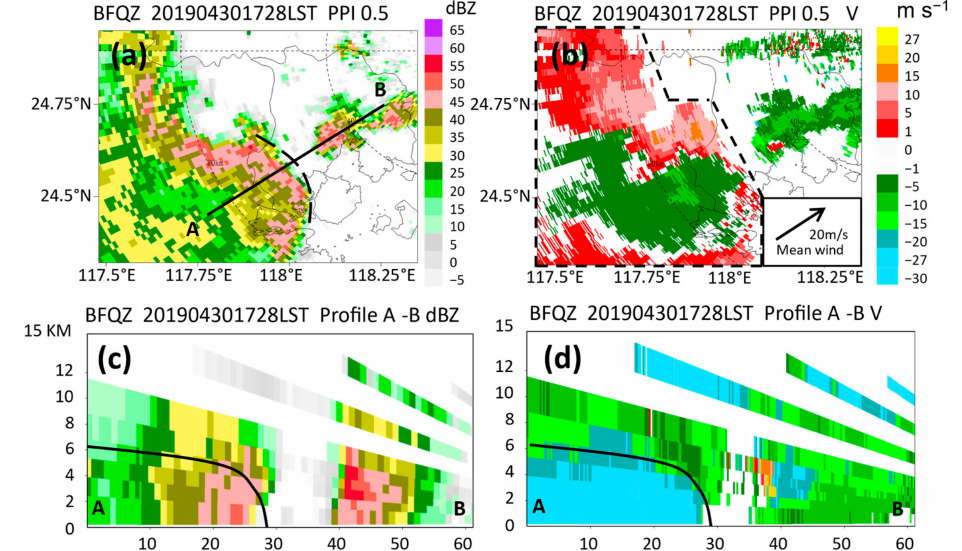
Figure 8. ( a ) Reflectivity (shaded; unit: dBZ) of BFQZ at 0.5 ◦ PPI at 17:28 LST. Doppler velocity (shaded; unit: m s − 1 ; dashed area; storm-relative velocity; the storm motion is shown in the bottom- right panel) ( b ) and their corresponding cross-sections of ( c ) reflectivity (shaded; unit: dBZ) and velocity (shaded; unit: m s − 1 ) ( d ) along black lines A and B in ( a